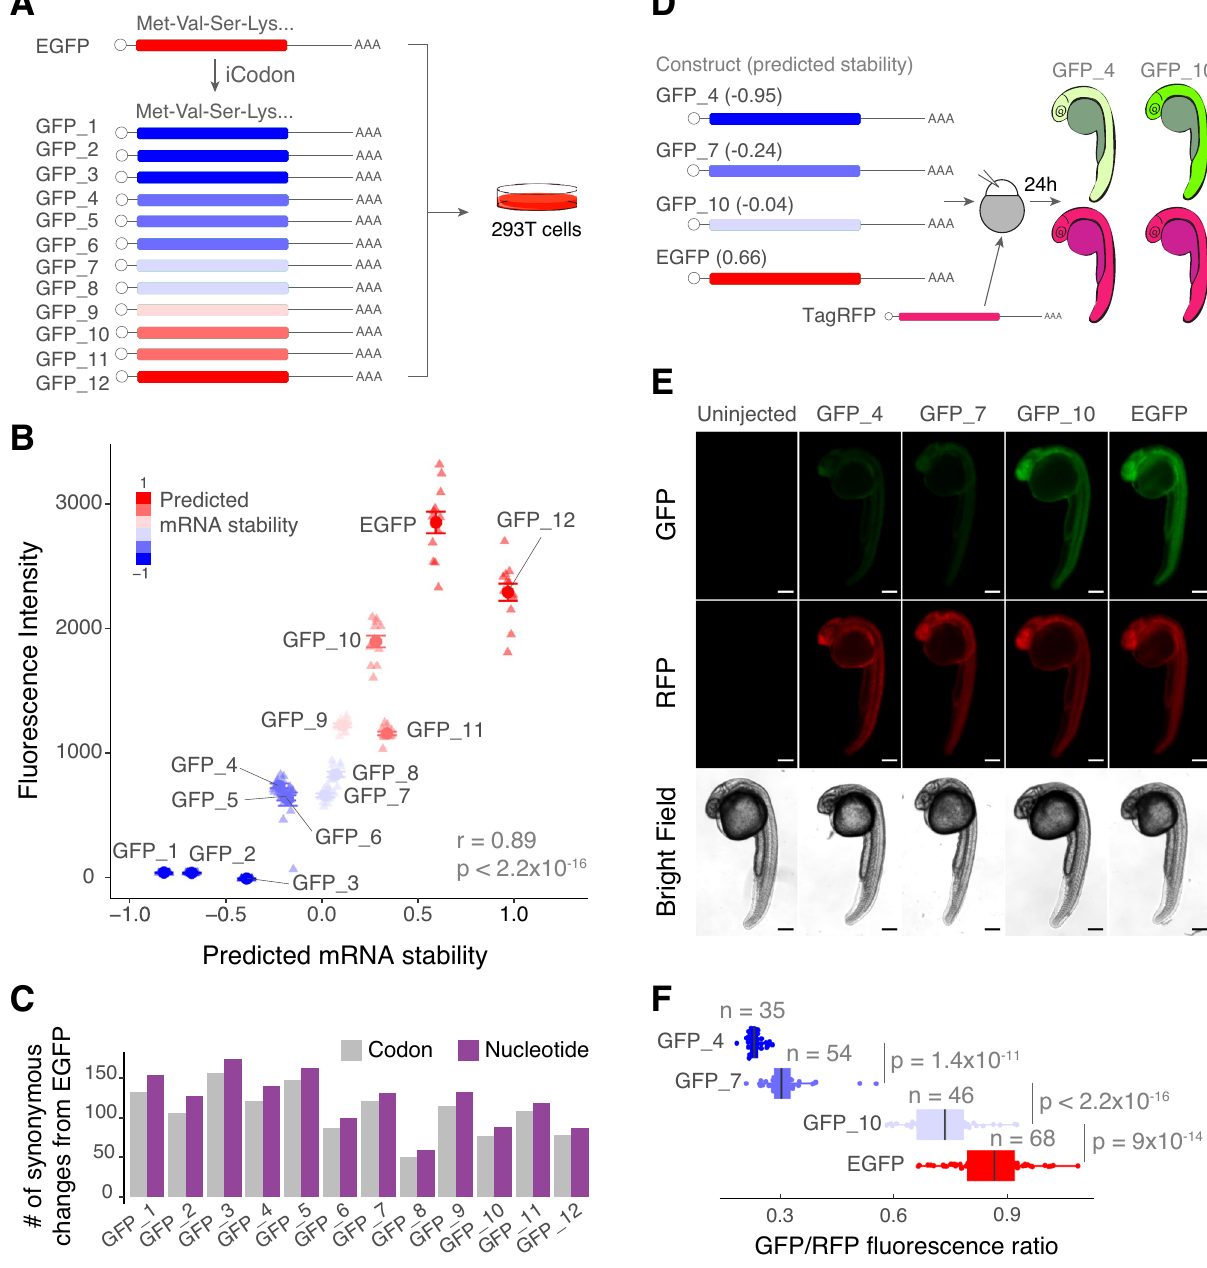
Figure 3. iCodon generates fluorescent variants with desired expression levels. ( A ) Illustration of 12 GFP variants generated by iCodon differing only in synonymous mutations and its predicted mRNA stability. All GFP variants were transfected in 293T cells and the fluorescence was measured by cytometry analysis. ( B ) Scatter plot showing a positive correlation between predicted mRNA stability and GFP fluorescence intensity in 293T transfected cells (r = 0.89, p < 2.2 × 10 –16 , Pearson correlation test). n = 12 for all tested variants. ( C ) Barplot displaying the number of codon (gray) or nucleotide (purple) changes in all 12 GFP variants compared to EGFP. ( D ) Four GFP variants were co-injected with TagRFP into 1-cell stage zebrafish embryos and imaged 24 h post injection (hpi). The mRNA stability predictions by iCodon in zebrafish are indicated in brackets. iCodon predictions are slightly different for zebrafish compared to humans as codon optimality is not identical between these two species. ( E ) Microscopy images of injected zebrafish embryos after 24 hpi. Scale bars represent 200 µm. ( F ) Quantification of the differences of fluorescence intensity of GFP relativized by RFP fluorescence from injected zebrafish embryos. p values and replicates (n) are